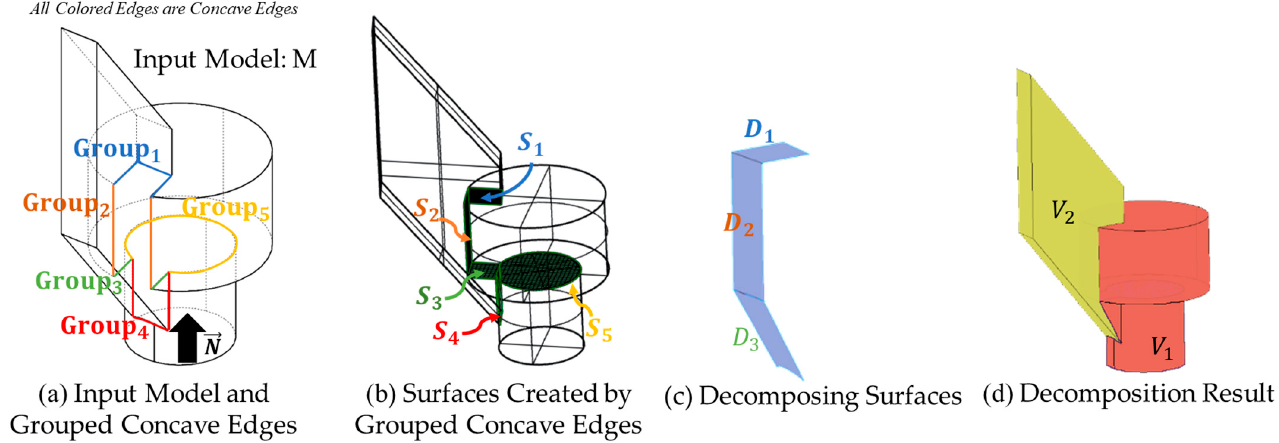
Figure 7. Visualized workflow of Algorithm 1.